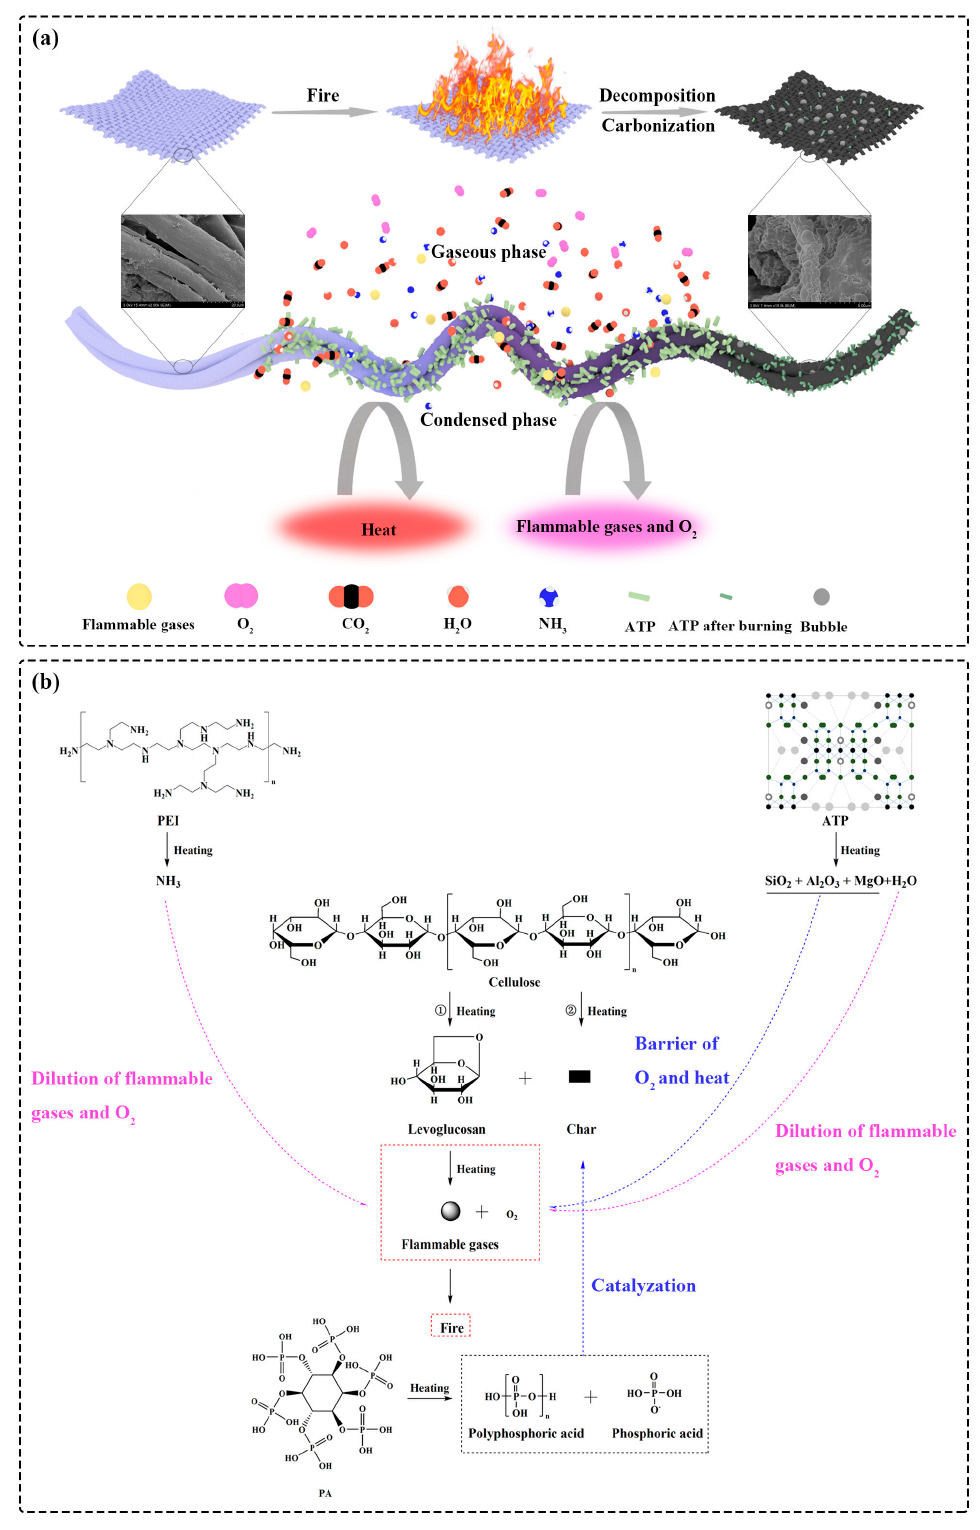
Figure 7. Schematic illustration of the intumescent flame-retardant mechanism during ( a ) the com- bustion process and ( b ) its specific chemical